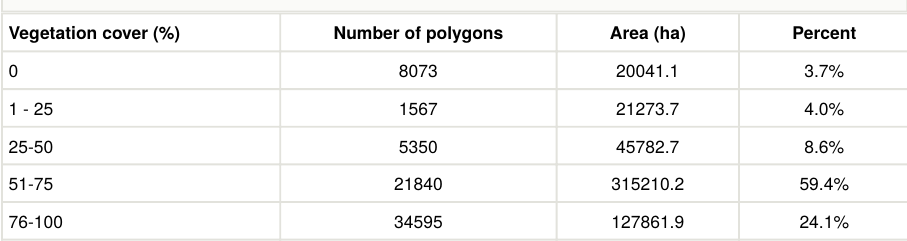
Distribution of vegetation cover of urban ecosystems in Bulgaria.